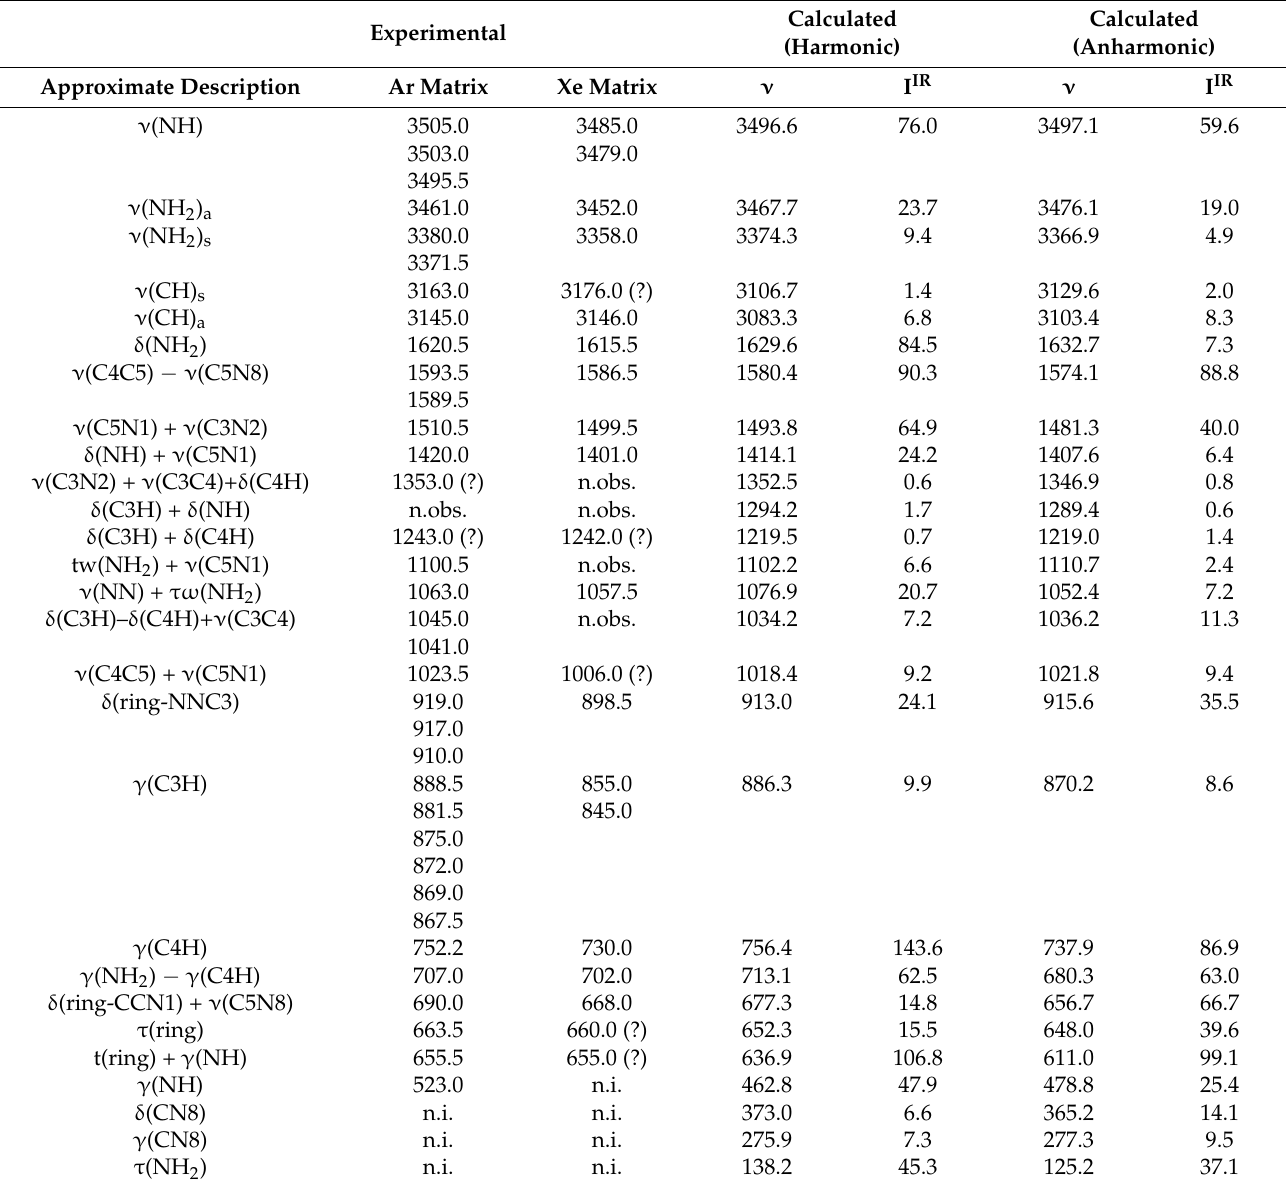
Table 3. Experimental IR bands assigned to 5AP isolated in Ar and Xe matrices and DFT(B3LYP)/6-311++G(d,p) calculated IR data for 5AP, with tentative assignments a